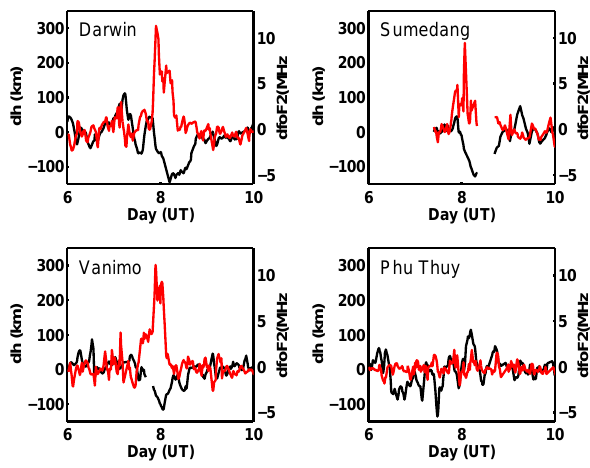
Fig. 9. Plotted differences in fo F2 (black) and virtual height (red) from median values over the period 6–13 November 1997 (storm 3) from ionosondes at Darwin, Sumedang, Vanimo and Phu